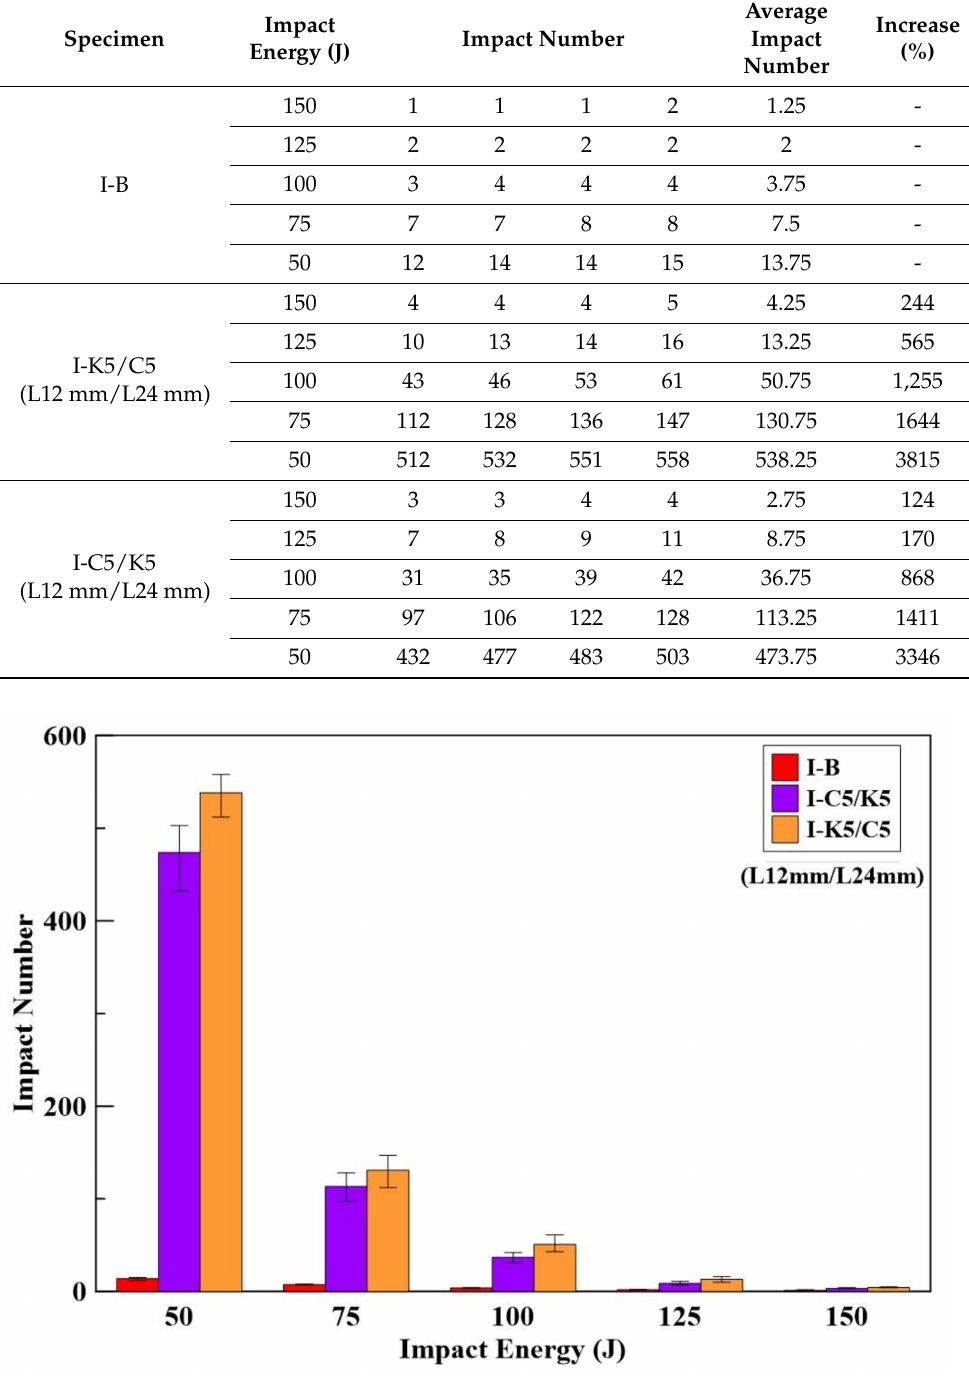
Figure 11. Bar chart for impact energy–impact number relationship of the benchmark and HFRC